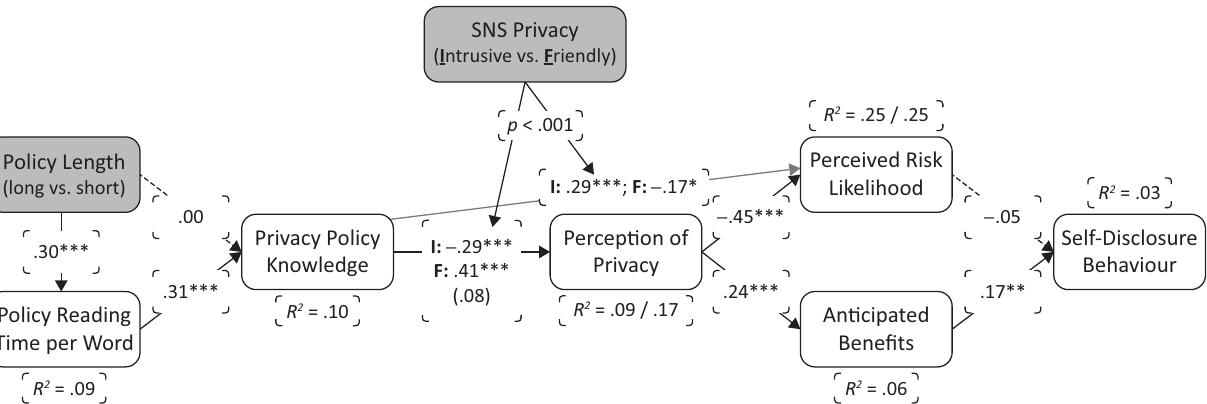
Figure 2. SEM with observed variables. Notes: The gray line was added in the multigroup analysis based on modification indices. Numbers display standardized regression coefficients ( 𝛽 ). When two R 2 values are displayed, these are part of the multigroup analyses (privacy-intrusive condition first, privacy-friendly condition second). Numbers in brackets shows the effect size without group effects. Dashed lines indicate non-significant paths. * p < .05, ** p < .01, *** p < .001. TLI = 1.00, RMSEA = .01 (90% CI: .00, .05), SRMR =